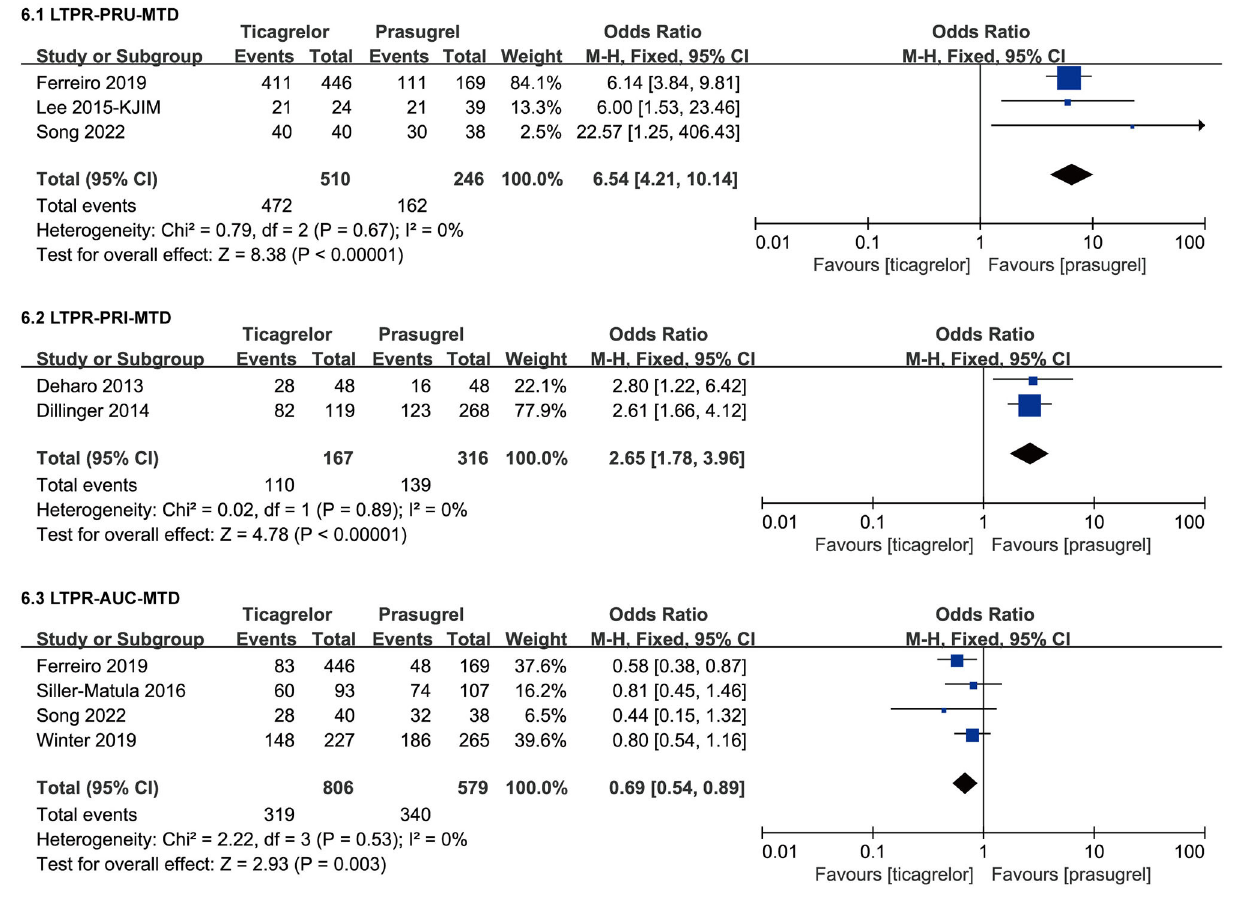
FIGURE 9 | Forest plots of meta-analysis results of LTPR after